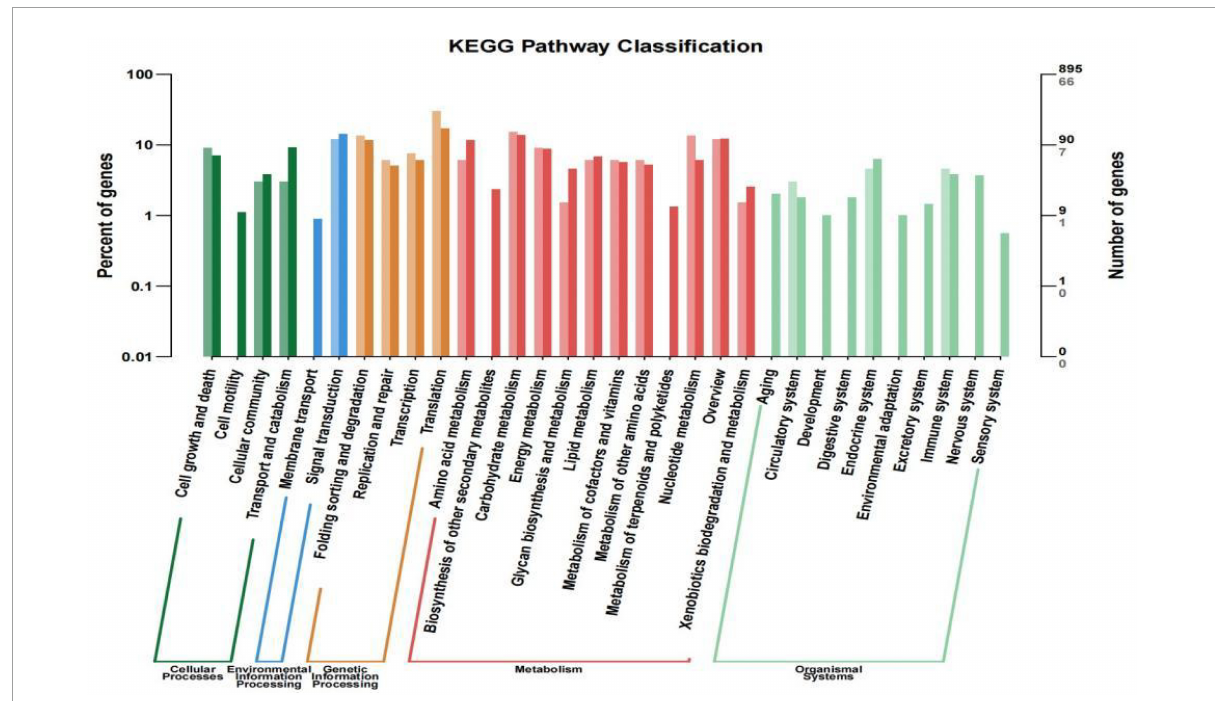
FIGURE5 KEGG pathway enrichment analysis results for the Wyslmt strain. Functional categories are shown on the horizontal axis, while the vertical axis corresponds to the number of genes per category (right) and the percentage of the total number of annotated genes (left). Different categories are marked with different colors. Differentially expressed genes and all genes are shown in lighter and darker colors, respectively.